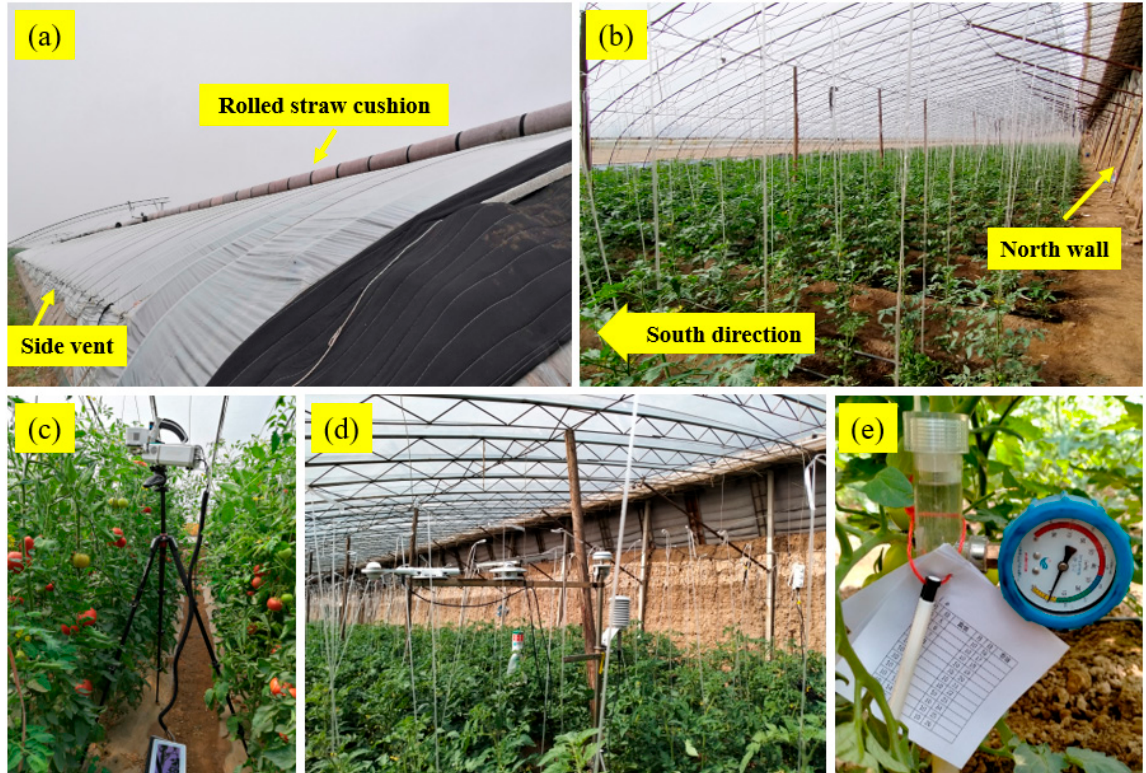
Figure 1. Combined photos of the sunken solar greenhouse and sensors’ deployment. ( a ) Outside placing on the top of the roof, ( b ) Inside view with tomato growth, ( c ) Photosynthetic parameters measurement by the LI-6800 portable photosynthesis system, ( d ) A view of the meteorological station inside the greenhouse, ( e ) Soil matric potential measurement using a dial-type